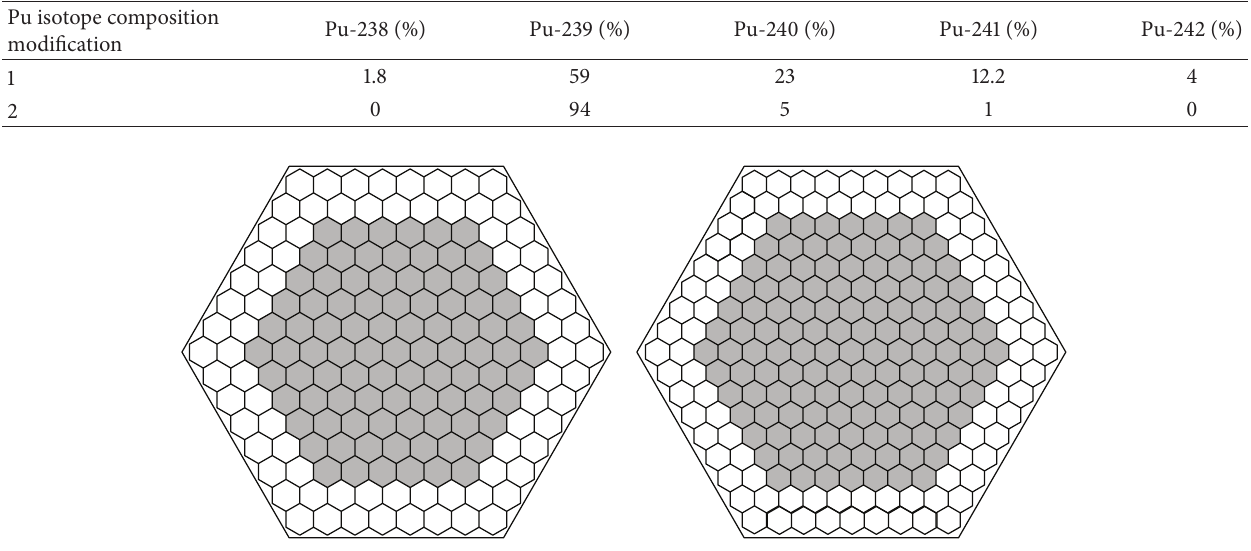
Table 2: Isotope composition of Pu in FPs of HTGTR.